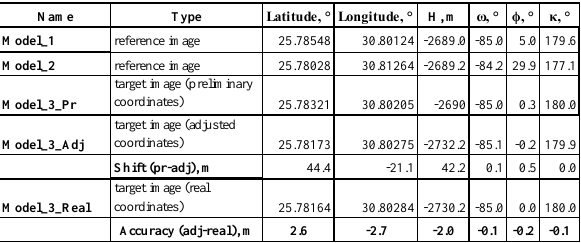
Table 1. Exterior orientation parameters of modelled images and results of their adjustment with 5 control